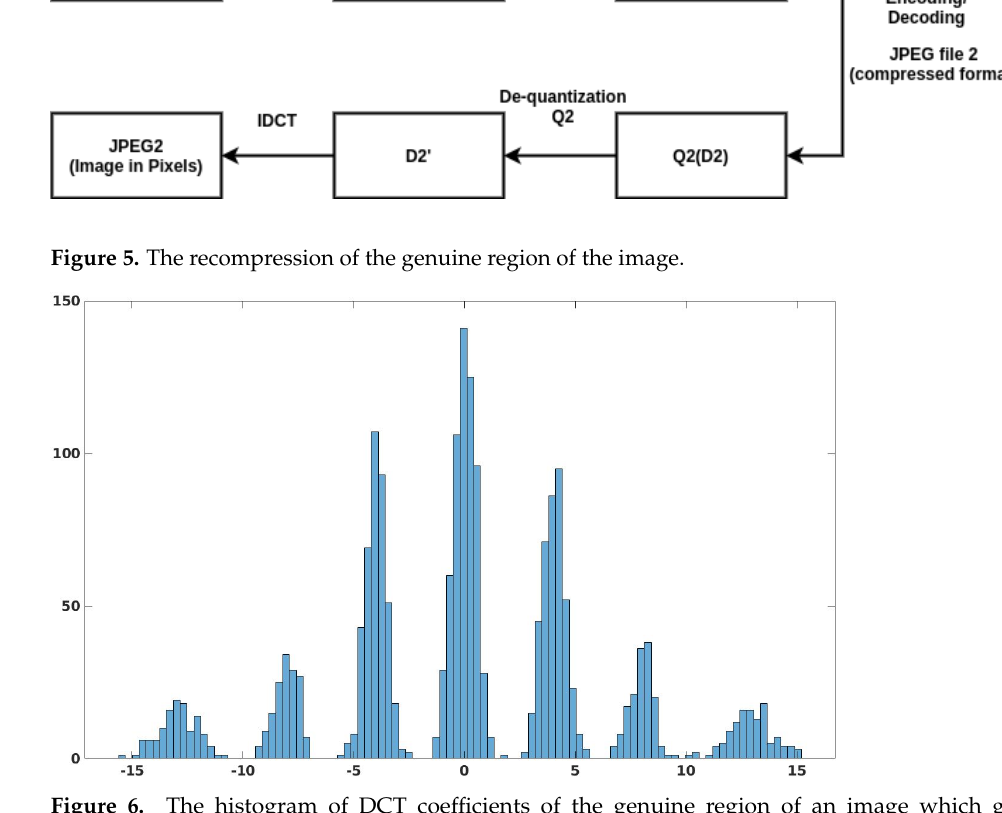
Figure 6. The histogram of DCT coefficients of the genuine region of an image which gets double